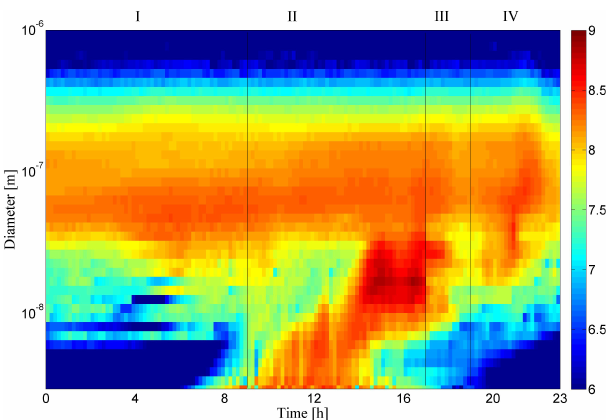
Fig. 2c. The total number concentrations for particles larger than 3nm for x EKF (solid; blue) and x INV (dashed;